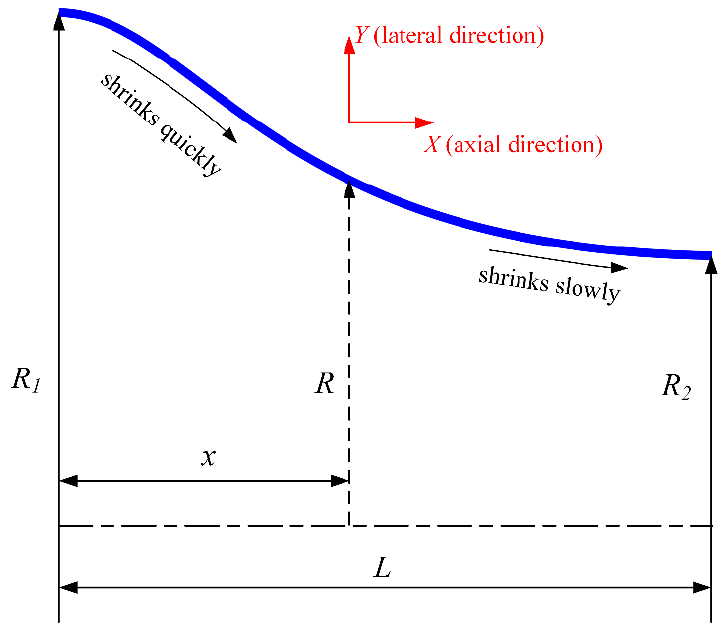
Figure 2. Vitoshinsky curve.